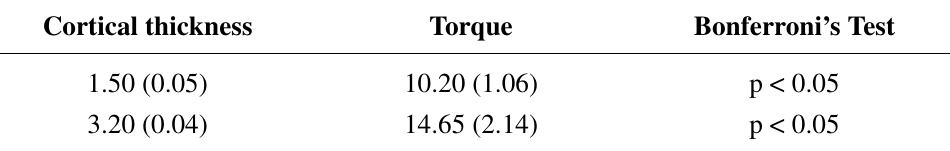
Table 3. Mean values (standard deviations) of cortical bone thickness (mm) of rabbit tibia measured by micor-CT scans and insertion torque (N ¨ cm) of 6 mm screw length. Correlation between same rows were performed by an analysis of variance with Bonferroni’s test at p =